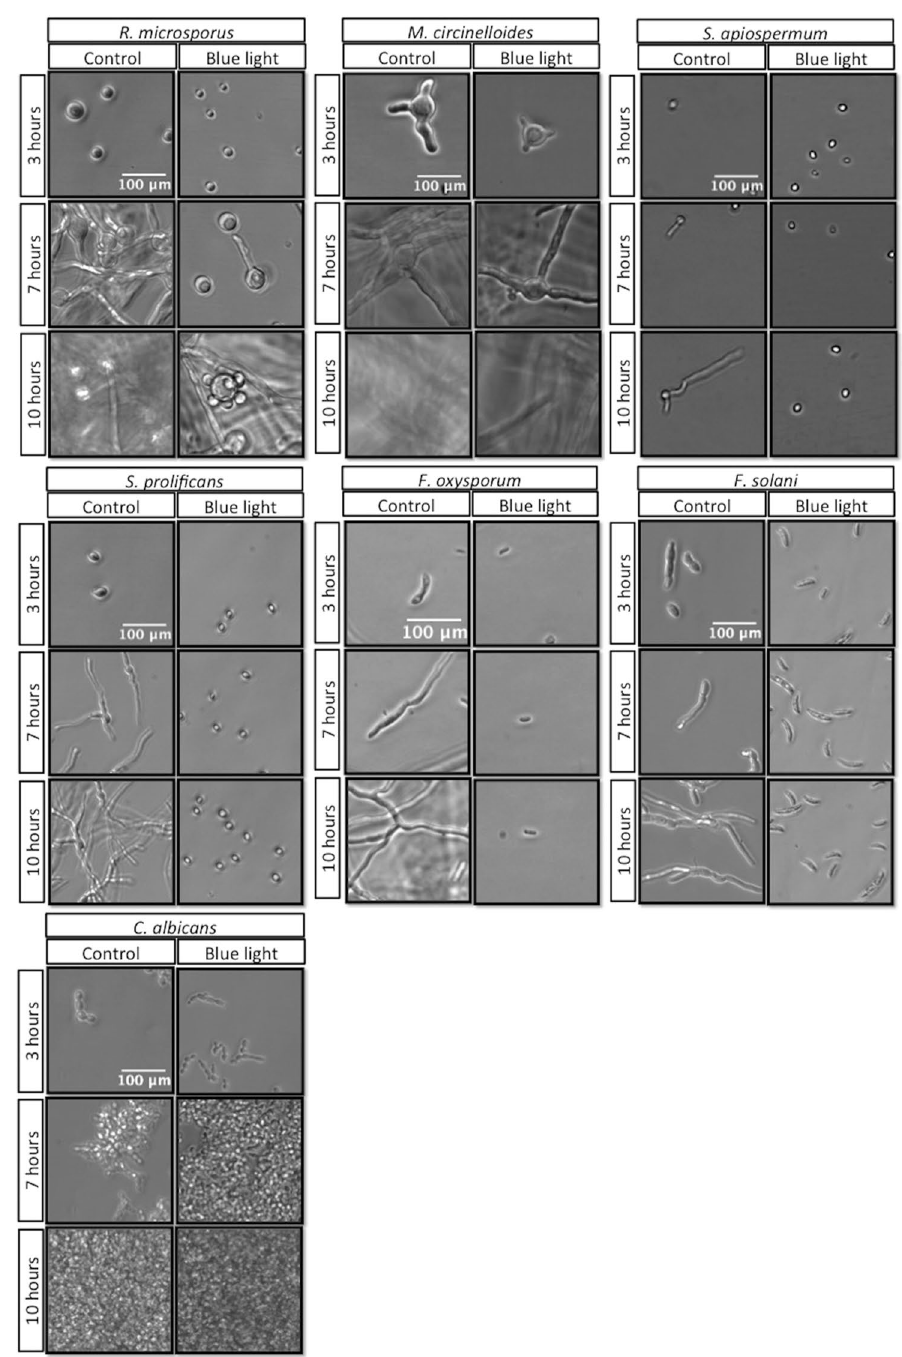
Figure 2. Visualization of blue light effect on fungal spores and cells. Time-lapse imaging shows that blue light 60 min treatment (216J/cm 2 ) under controlled temperature conditions is effective against S . prolificans and F . solani species but not C . albicans or